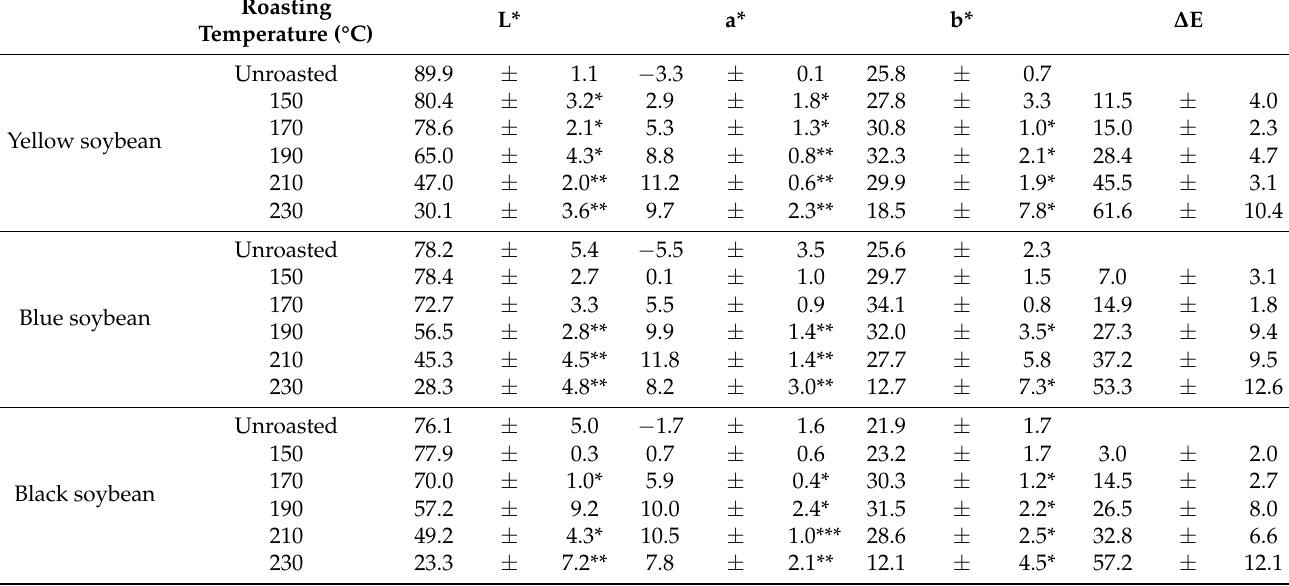
Table 2. Changes in color values of soybeans by roasting at various temperatures.